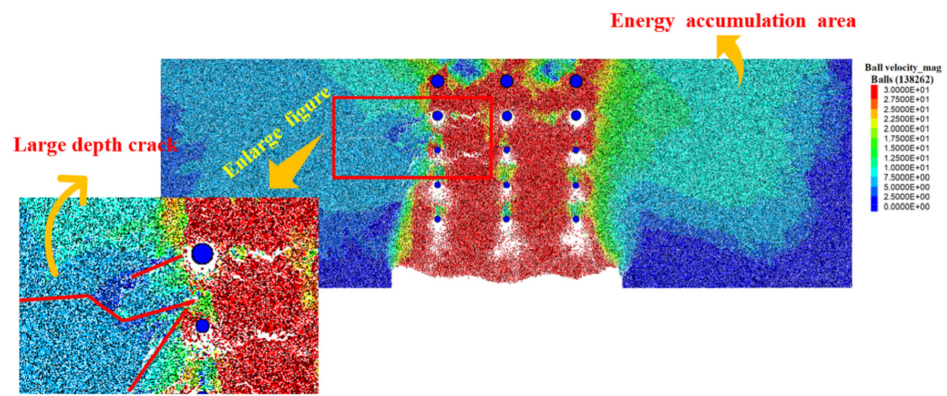
Figure 8. Sketch of blasting effects.